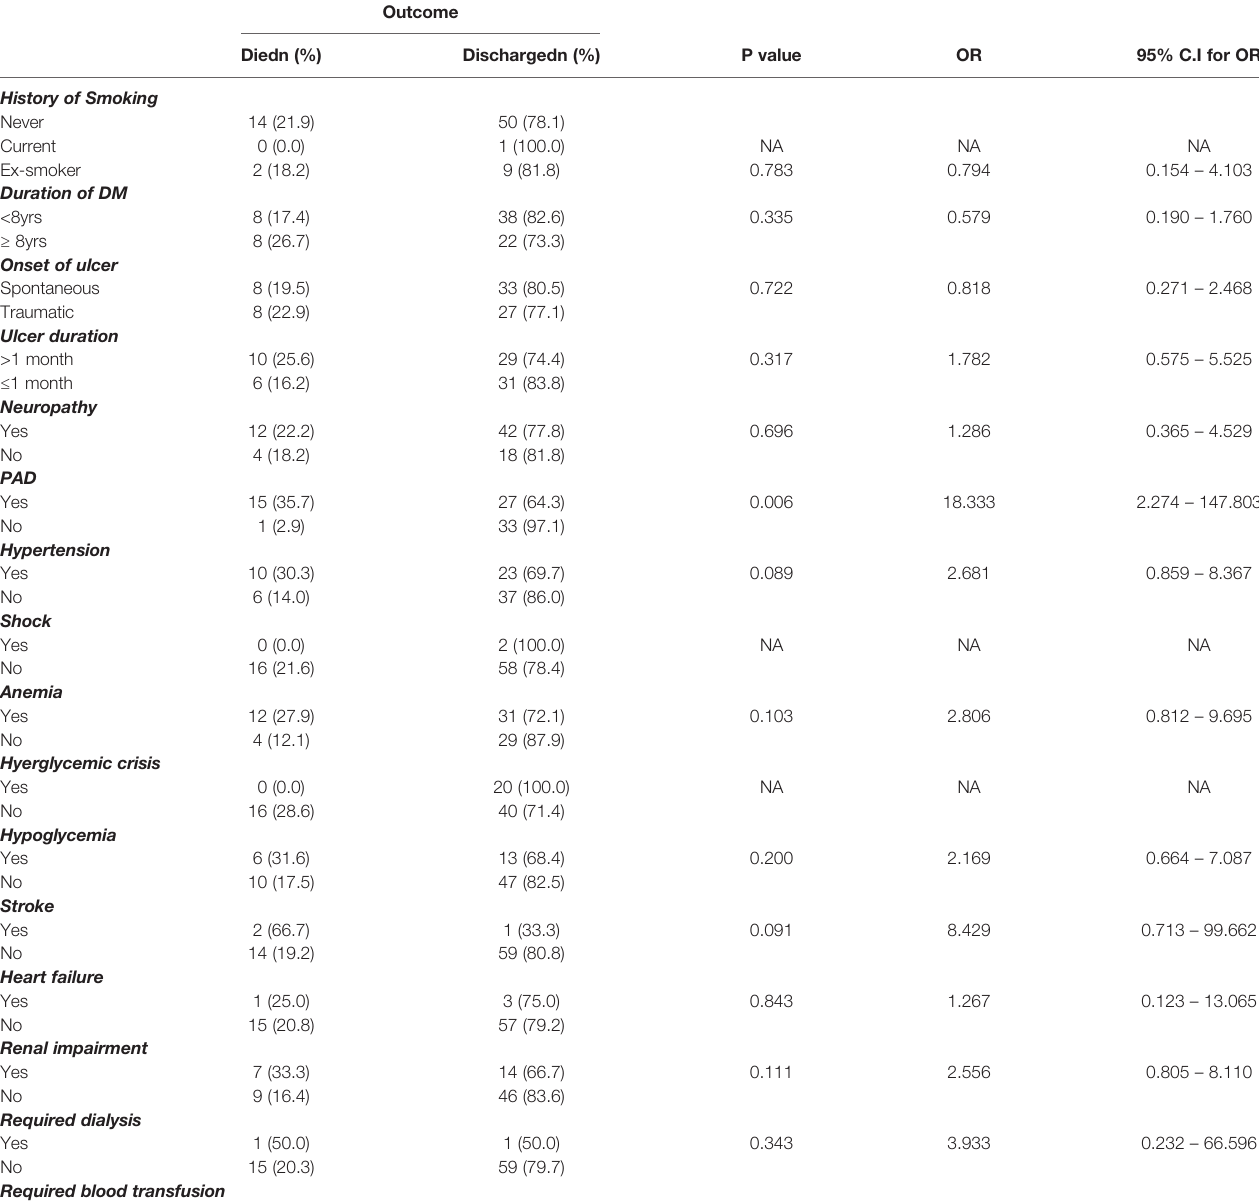
TABLE 3 | Relationship between some demographic and clinical variables and mortality. Outcome Diedn (%) Dischargedn (%) P value OR 95% C.I for